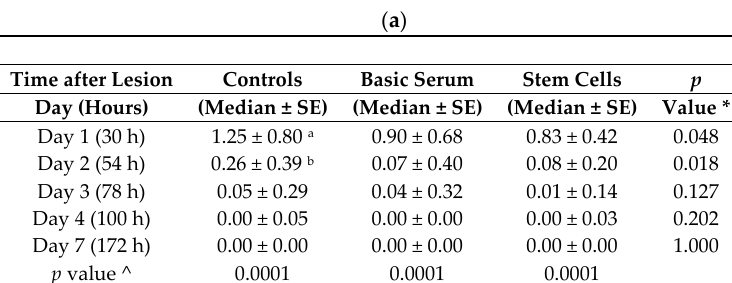
Table 1. ( a ) Median fluorescein positive corneal lesion area (mm 2 ) in mice for each group over time. ( b ) Number Ki67 cells in the peripheral and central post-lesion corneal epithelium and stroma in the different treatment groups at day 3 and day 7 after lesion (mean of total number of cells in three sections per corneal sector).